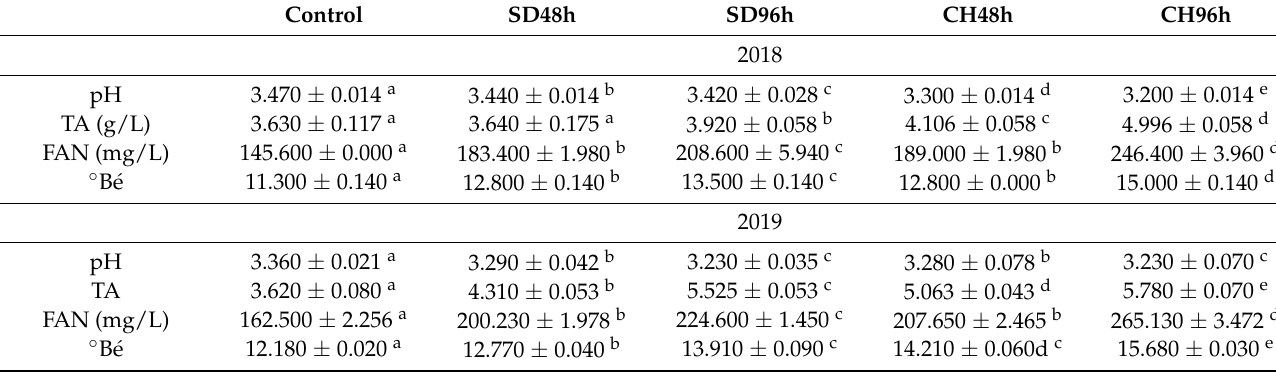
Table 1. Grape must physicochemical composition after grape over-ripening treatments. Control SD48h SD96h